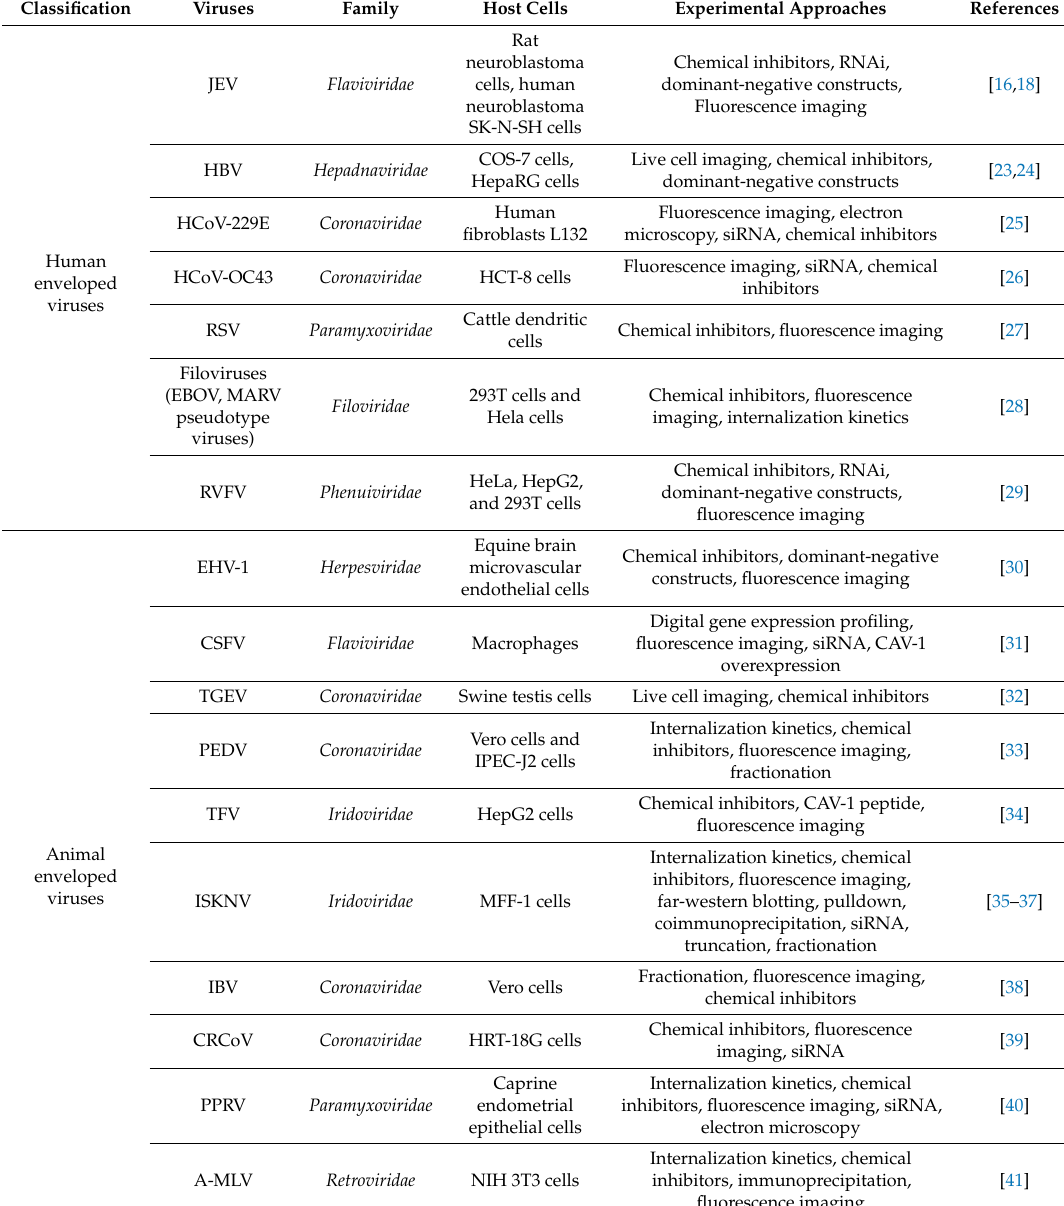
Table 1. Summary of viruses that enter host cells via caveolae-mediated